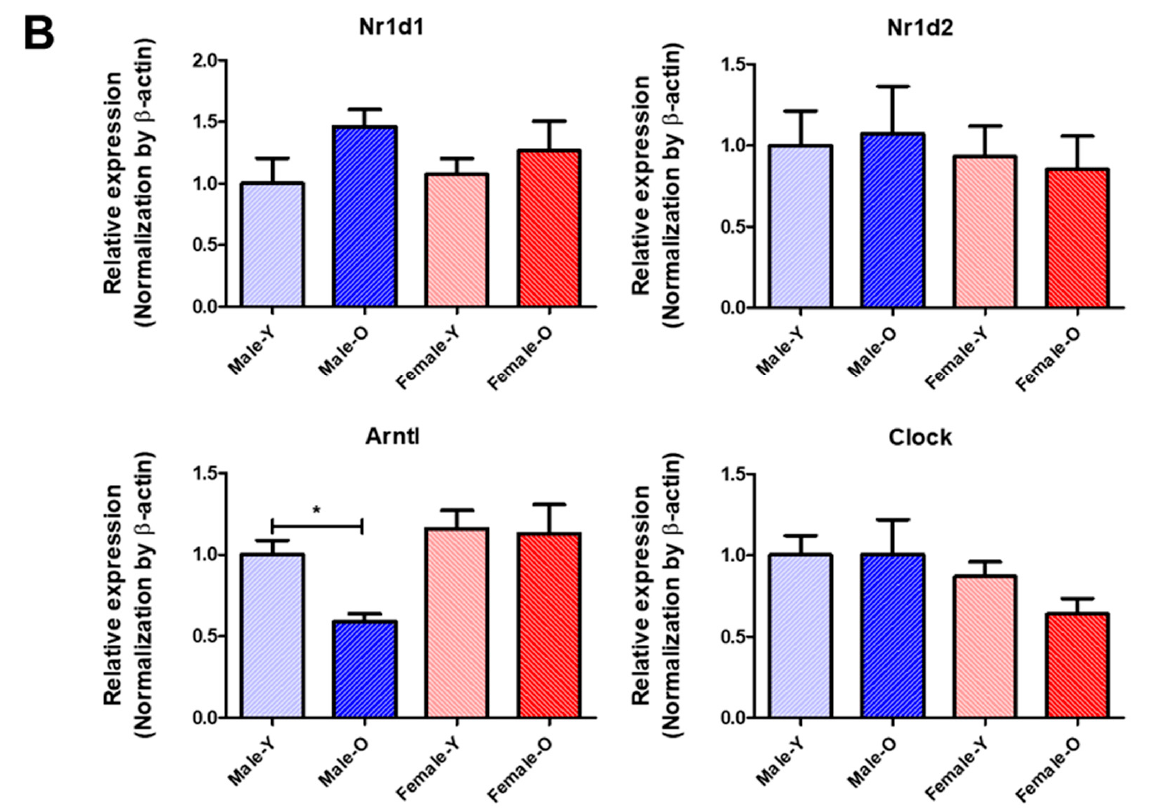
Figure 5. Protein expressions of Nr1d1/2, Arntl, and Clock which were differentially expressed according to sex and age in SD rats ( n = 4 or 6 per group). ( A ) Representative band images of Nr1d1/2, Arntl, and Clock. ( B ) Relative expression of Nr1d1/2, Arntl, and Clock. These proteins showed sex differences in their expression during liver aging. Nr1d1, nuclear receptor subfamily 1 group D member 1; Nr1d2, nuclear receptor subfamily 1 group D member 2; Arntl, aryl hydrocarbon recep- tor nuclear translocator like; Clock, clock circadian regulator; Y, young; O, old. * p < 0.05 between the two groups.